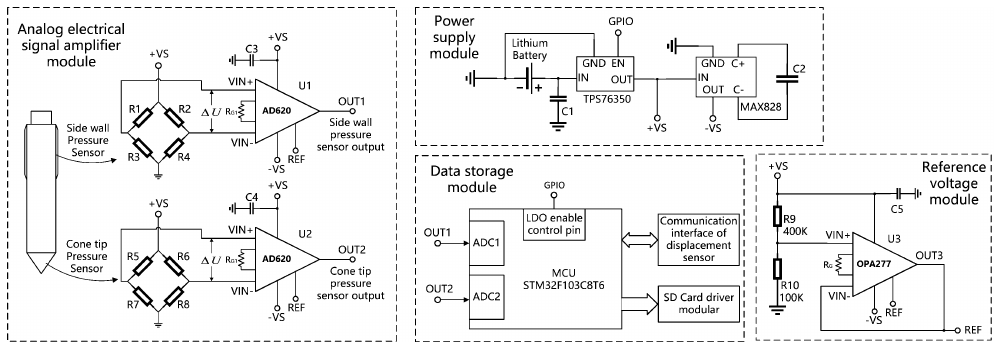
Figure 4. Diagram of analog voltage amplification and acquisition circuit.